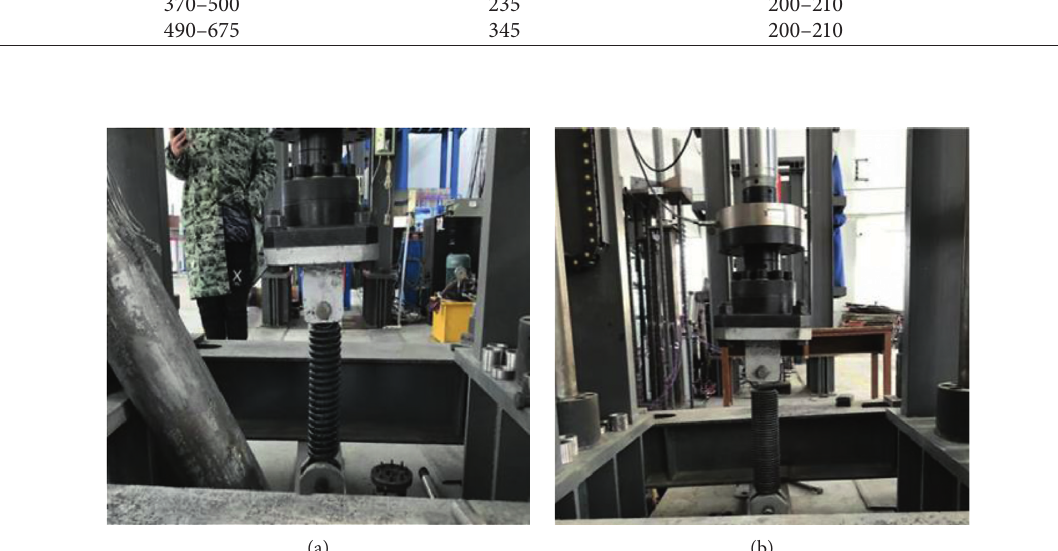
Figure 2: Test setup of tension spring. (a) Tension test of spring S1. (b) Tension test of spring S2.